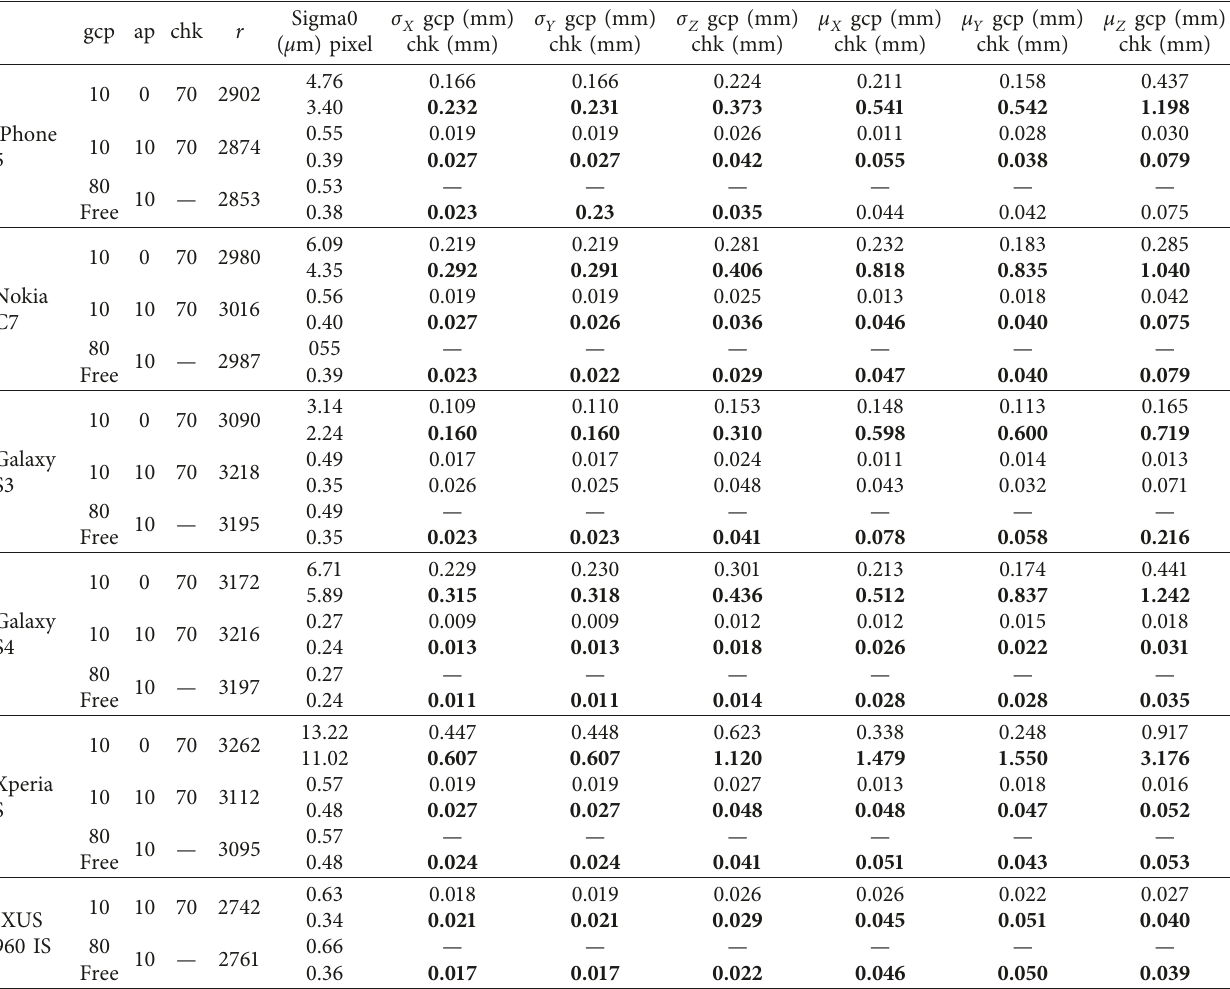
Table 2: Results of bundle